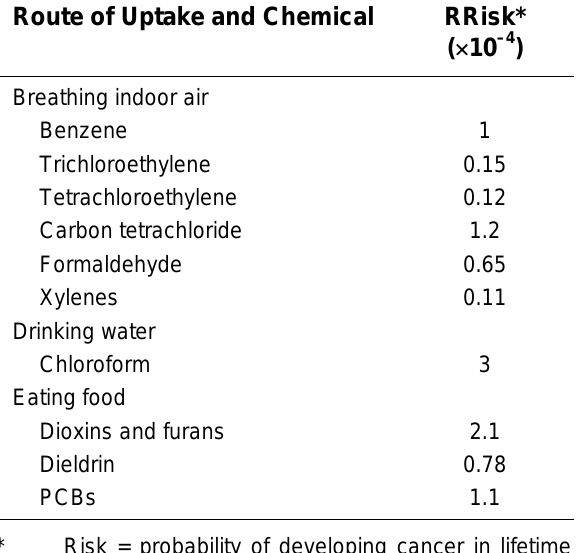
The Risk of Uptake of 10 Selected Hydrocarbons Route of Uptake and